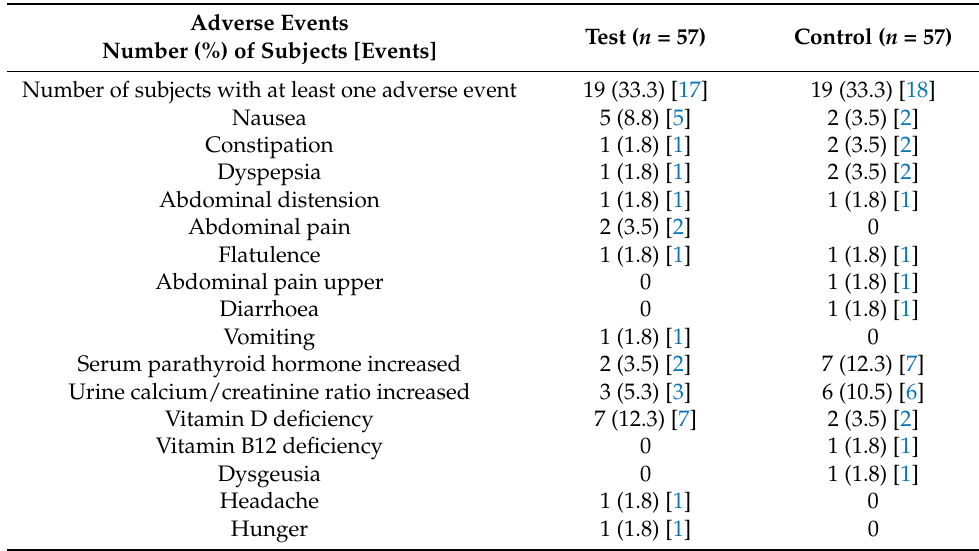
Table 7. Summary of adverse events—Safety population. Adverse